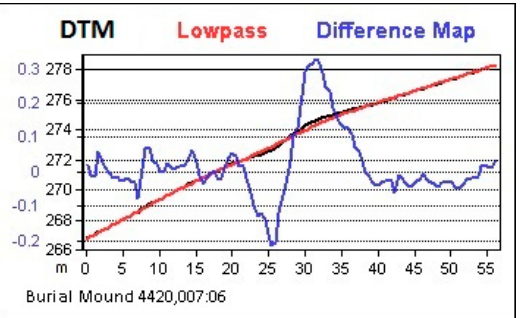
Figure 7. Profile graphs of a Burial Mound in a digital terrain model (DTM) (black), a smoothed DTM (red) and the final Difference Map (blue) [13].